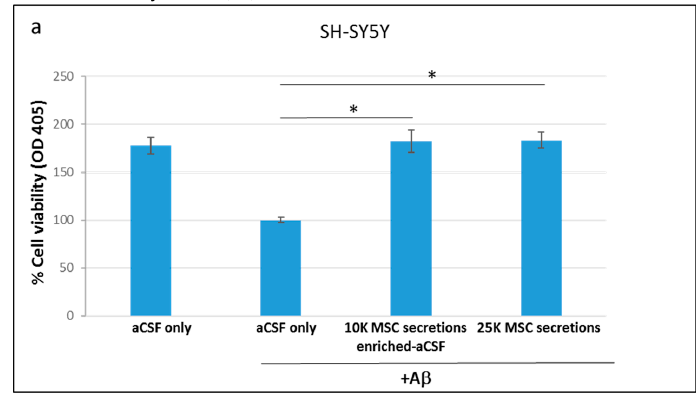
Figure 2. Enriched-aCSF increases cell viability of neuronal cell lines exposed to A β neurotoxin. ( a ) While SH-SY5Y cell viability was reduced under A β , a significant increase in cell viability was noticed